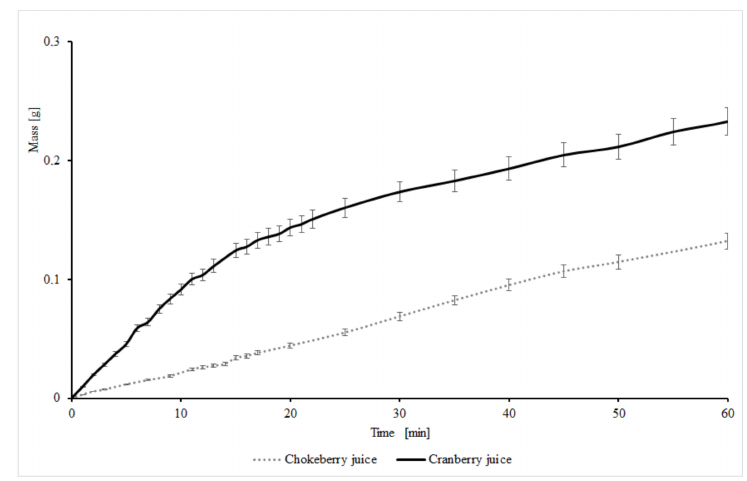
Figure 1. E ff ect of weight change in juices as a result of carbon dioxide evolution in reaction with eggshells.